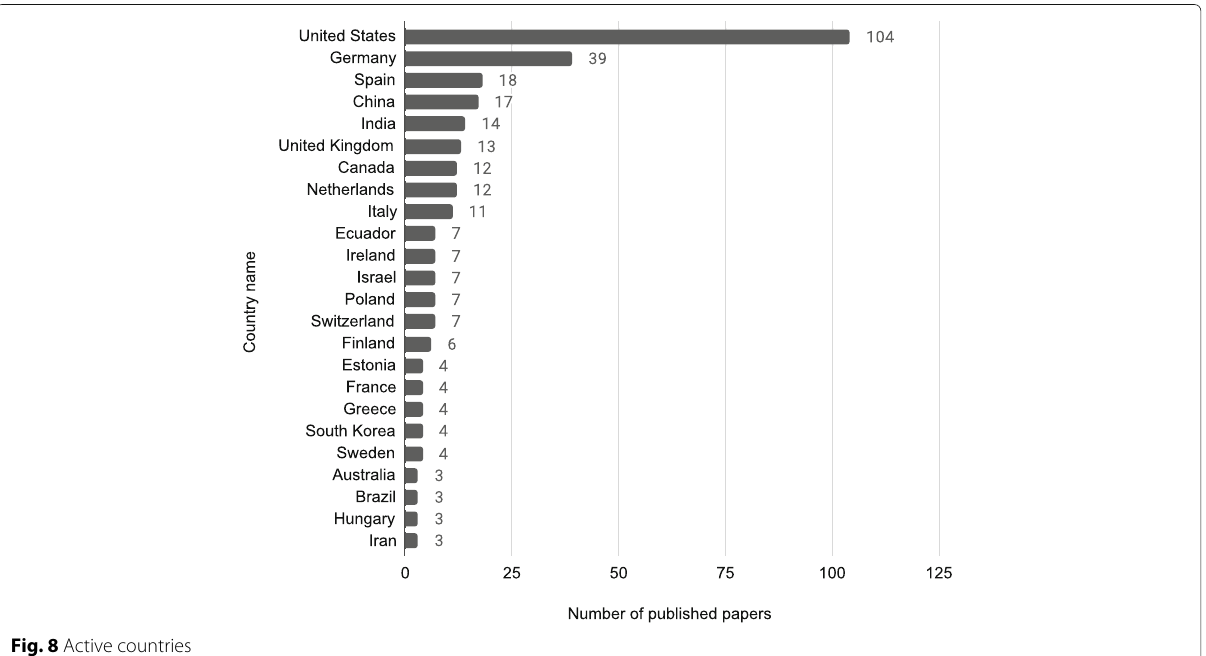
known commercial systems are AWS Lambda, Google Cloud Functions, and Azure functions. Alternately, there are several open source platforms available including IBM Cloud Functions, and Apache OpenWhisk.